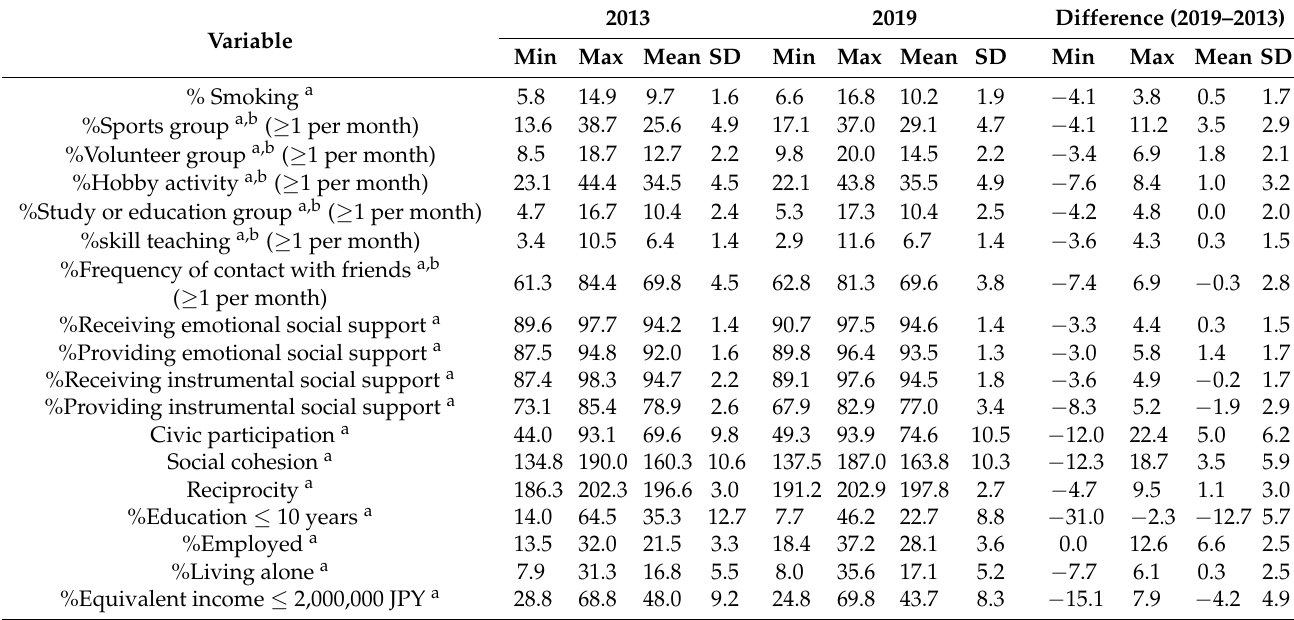
Table 1. Age-adjusted descriptive statistics factors (Municipal units = 69).